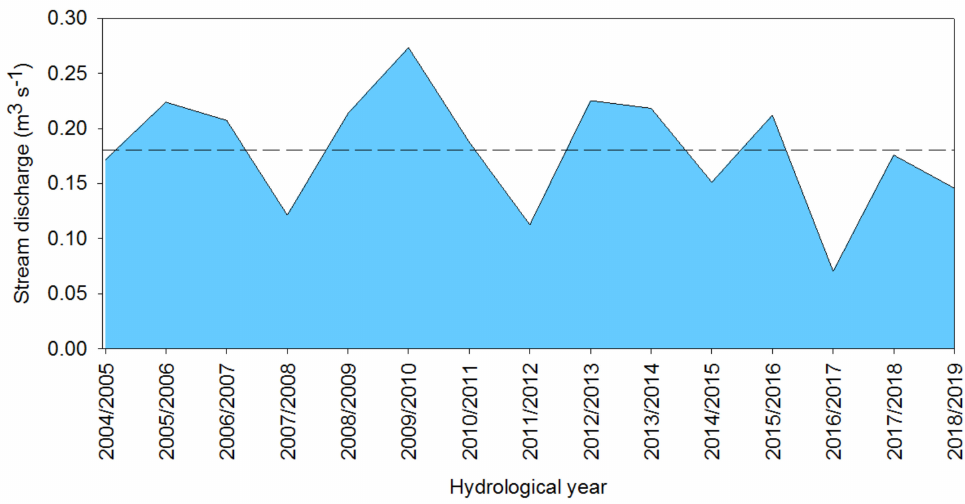
Figure 3. Variations in stream discharge in Corbeira catchment (2004 / 2005–2018 / 2019). Horizontal dotted line indicates the mean for the study period.